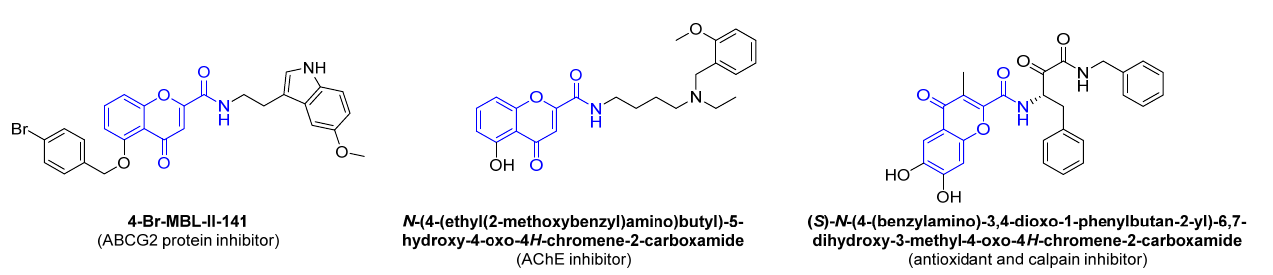
Figure 2. Structure of some bioactive chromone carboxamide based compounds [16–18].